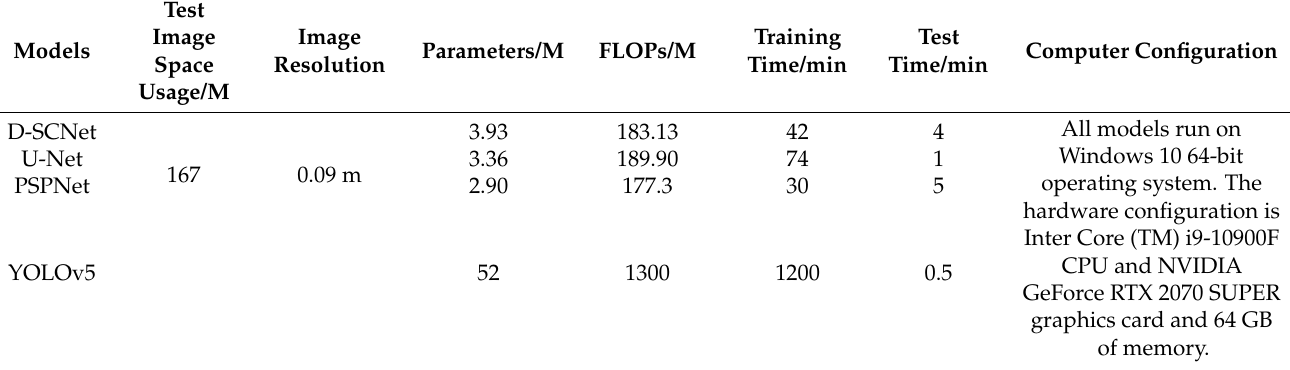
Table 7. Accuracy evaluation of this method test